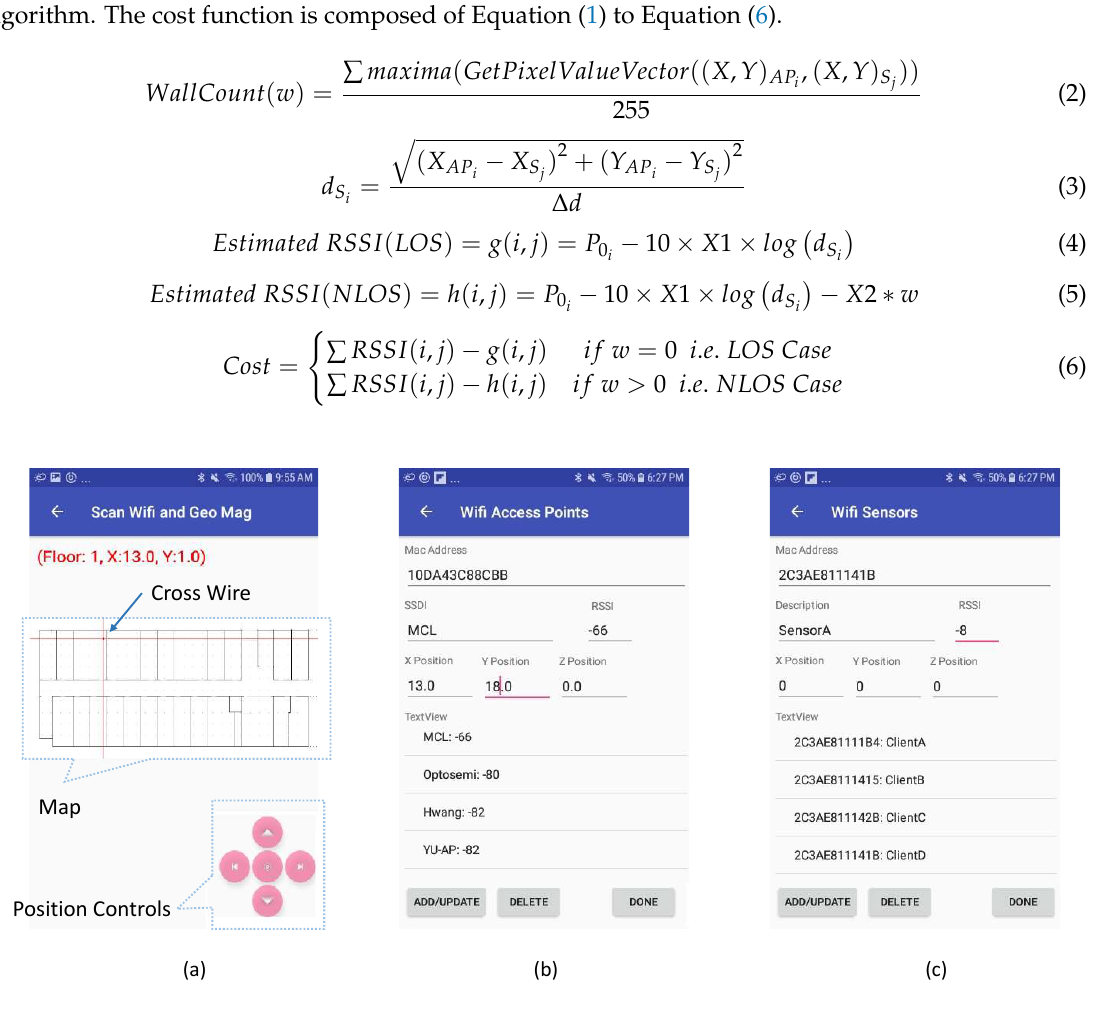
Figure 5. Smart-phone utility interfaces. ( a ) Positioning on Map, ( b ) Access point registration, and ( c ) Wi-Fi sensor